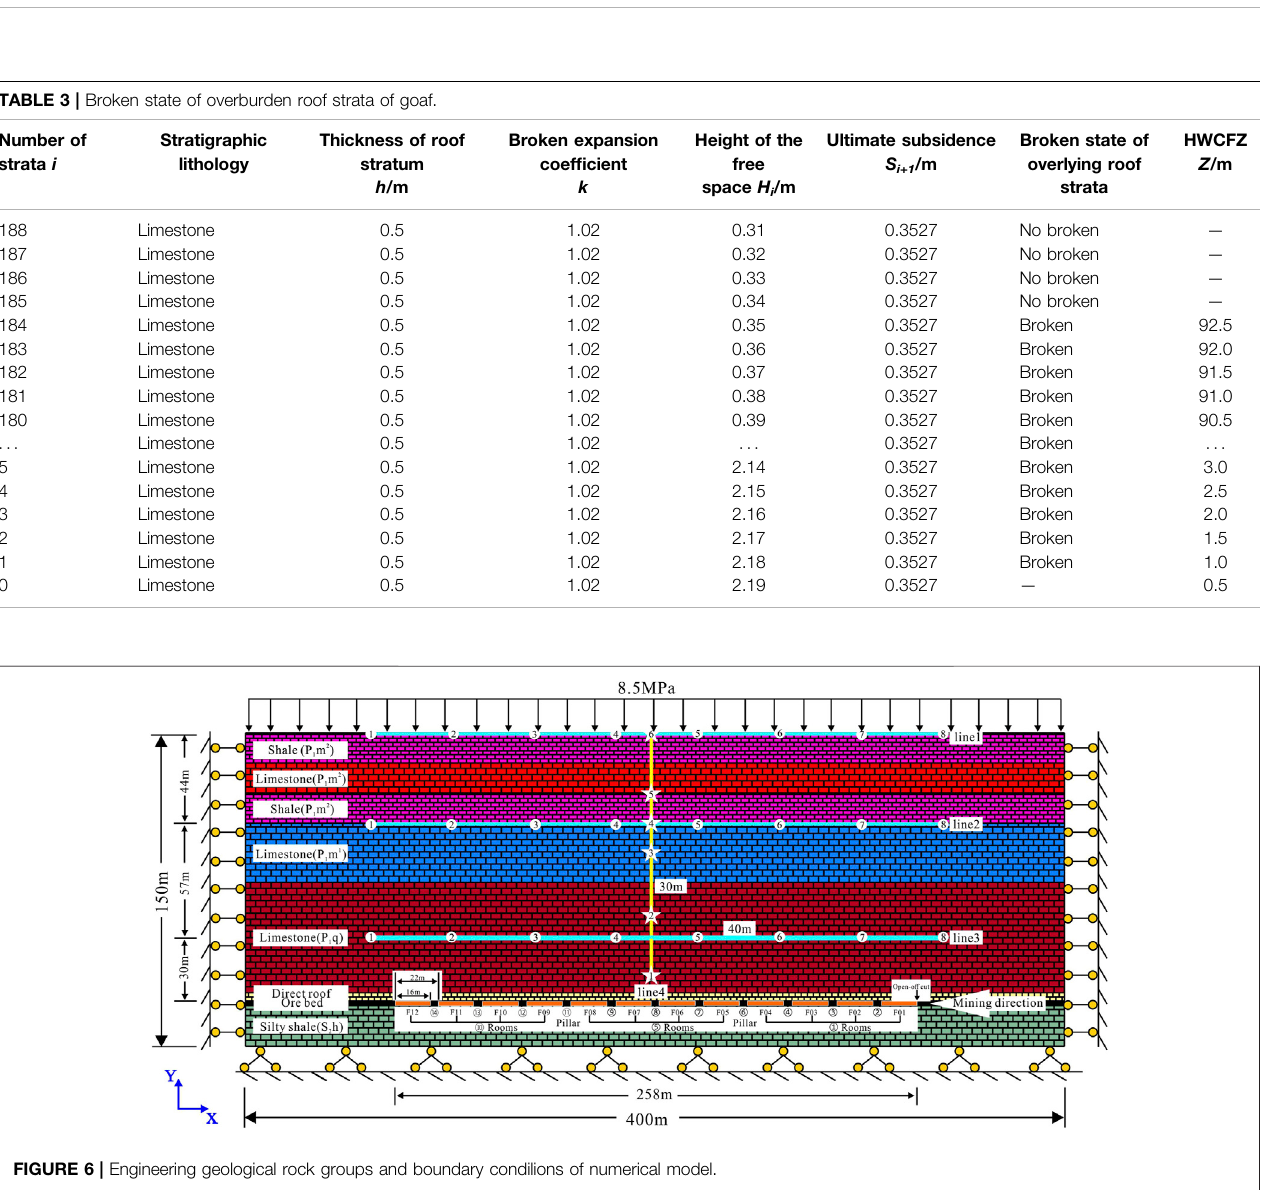
Frontiers in Earth Science |